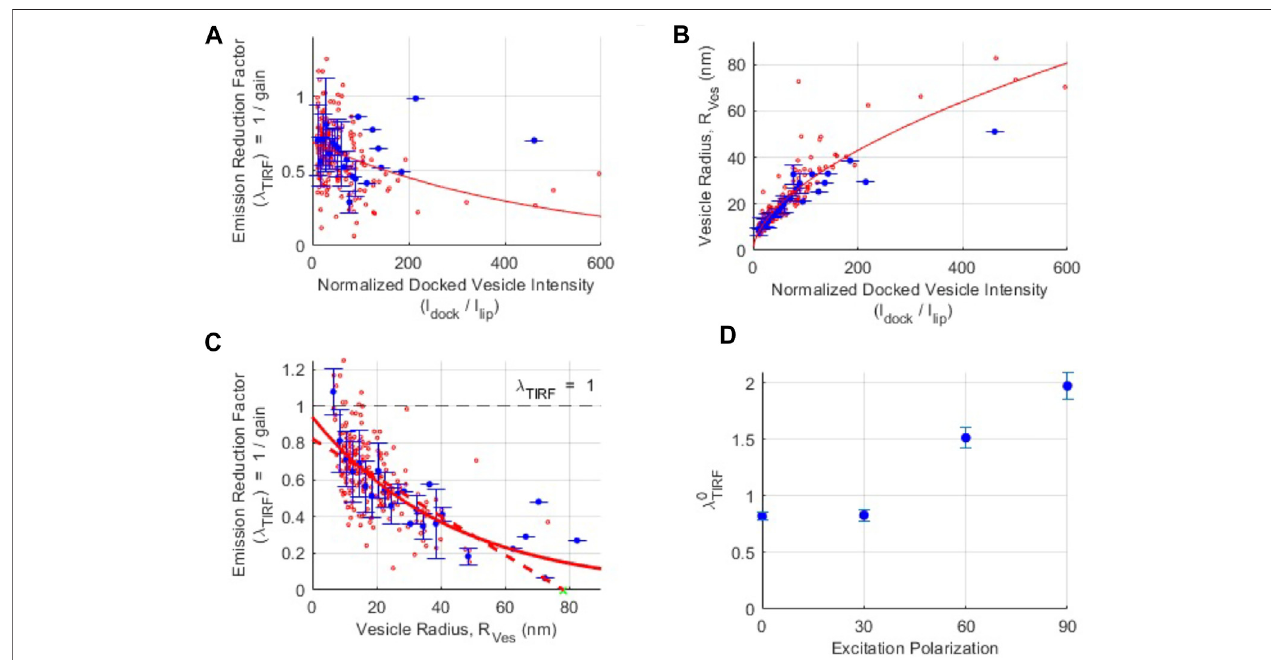
FIGURE 3 | Isolation of the pure polarization contribution to changes in fl uorescence intensity during SUV-SBL fusion. (A) The relationship between the fl uorescence intensity reduction factor λ fi t to an exponential, TIRF and docked SUV intensity I dock normalized by single lipid intensity in the SBL, I lip . The red curve is a λ (cid:1) a (− b ) , with best- fi t parameters (and 95% con fi dence intervals) a (cid:1) 0 . 69 (0.65, 0.74), and b (cid:1) 2 . 1 × 10 − 3 (1 . 1 × 10 − 3 , 3 . 1 × 10 − 3 ). The red dots fit 1 exp 1 I dock / I lip 1 1 represent individual events. The blue dots are binned values, with bin size (cid:1) 2. The error bars represent ± standard deviation (SD). (B) Vesicle radius, R ves , as a function of the normalized docked SUV intensity, I dock / I lip . The relationship is fi t to a power law, R ves , fit (cid:1) a 2 ( I dock / I SBL ) b 2 , with best fi t parameters a 2 (cid:1) 2 . 1 (1.7, 2.4), and b 2 (cid:1) 0 . 57(0.54,0.61).RedandbluedotsareasinA,withbinsize (cid:1) 2. (C) Fluorescenceintensityreductionfactor λ TIRF asafunctionofvesicleradius R ves .Thecontinuous red curve is an exponential fi t to the data, a 3 exp (− b 3 R ves ) , with best fi t parameters a 3 (cid:1) 0 . 94 ( 0 . 87 , 1 . 02 ) and b 3 (cid:1) 0 . 023 ( 0 . 019 , 0 . 028 ) . The red dashed line is a fi t to the small R ves values ( R ves ≤ 35 nm ) with the x -intercept constrained at the independently estimated evanescent fi eld depth, δ TIRFM (cid:1) 78nm (see text and Materials and Methods ). The y -intercept of this line, λ 0 TIRFM (cid:1) 0 . 82 ± 0 . 03, is our best estimate of the purely polarization contribution to the intensity change as a lipid-dye is transferred from a SUV into the SBL upon fusion. Red and blue dots are as in (A) , with bin size (cid:1) 1 nm. (D) Fluorescence intensity reduction factor due to pure polarization effects, θ . Estimates of λ 0 θ (cid:1) 30 ° , 60 ° and 90 ° were done similarly to (A – C) for θ (cid:1) 0 ° , see Supplementary Figure λ 0 TIRFM , as a function of excitation polarization angle, TIRFM at S5 . For A-C, 195 events were analyzed, for (D) , a total of 446 events were